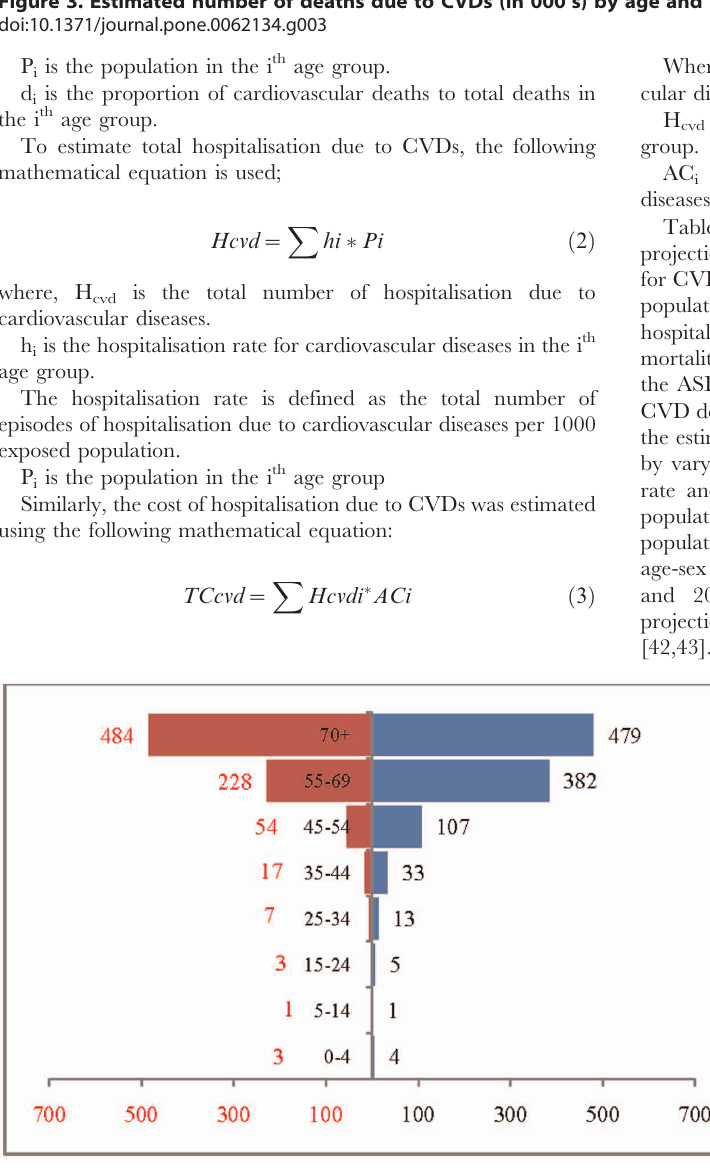
Figure 4. Estimated number of deaths due to CVDs (in 000’s) by age and sex, India, 2016.